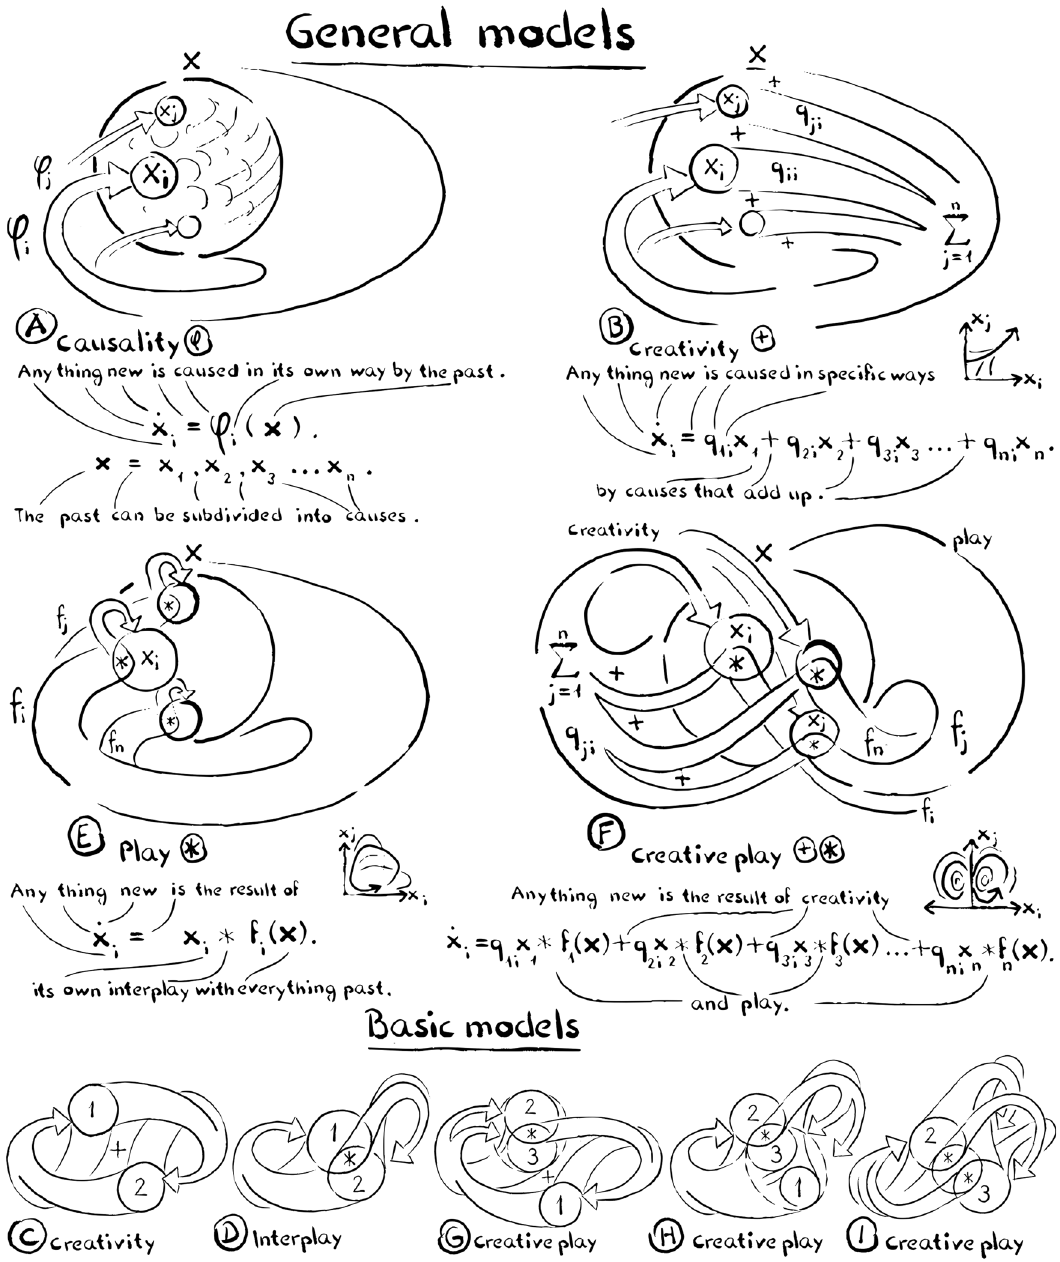
Fig. 2 Framework for causal modeling. Sketch of a uni fi ed framework for causal modeling. On the upper left is the most general description of causation, which is split into two special cases by introducing additions in B and multiplications in E. These two separate cases represent creativity and play, respectively. They are also reunited into a model of creative play, shown in F. Below are several basic (low dimensional) models useful for analysis. A Universally applicable model of causality according to which anything new is caused by the past. Causation is continuous change, which gives differential equations. x represents the past. _ x represents change that has presently occurred. B General model of creativity. Causes simply add up. The insertion of additions splits the world into different causes and allows for causal fl ows between them. These fl ows make causes related. This is the backbone of perturbation theory, quasispecies evolution, as well as a general model of creativity in human culture. It also serves as architecture for the layers of Neural Networks used in Arti fi cial Intelligence. C Basic model of creativity. The larger a fl ow is that links a cause and an effect, the more it makes them related. D Basic model of interplay. Variables are multiplied. This leads to equations of the Lotka – Volterra type. They are a basic model for ecology, virology, and diversi fi cation in human culture. Perhaps the drawing reminds you of a Venn diagram. The intersection between circles stays for AND, which computers use to calculate multiplications. E General model of interplay. This is also the backbone of game theory and compartmental models in all fi elds of study. It is also known as generalized Lotka-Volterra or replicator equation. F General model of creative play. This is the replicator-mutator-equation used across many disciplines. It unites models B and E. G – I Basic models of creative play. They behave once like creativity, once like interplay: Within G, there are two groups connected by creativity. Within H, there are two groups connected by interplay. I is the Lorenz system (Lorenz, 1963), known in popular literature for the “ butter fl y effect ” . The equations of these latter models are found in the section “ Equations ” . Source: Dan C. Baciu. License: